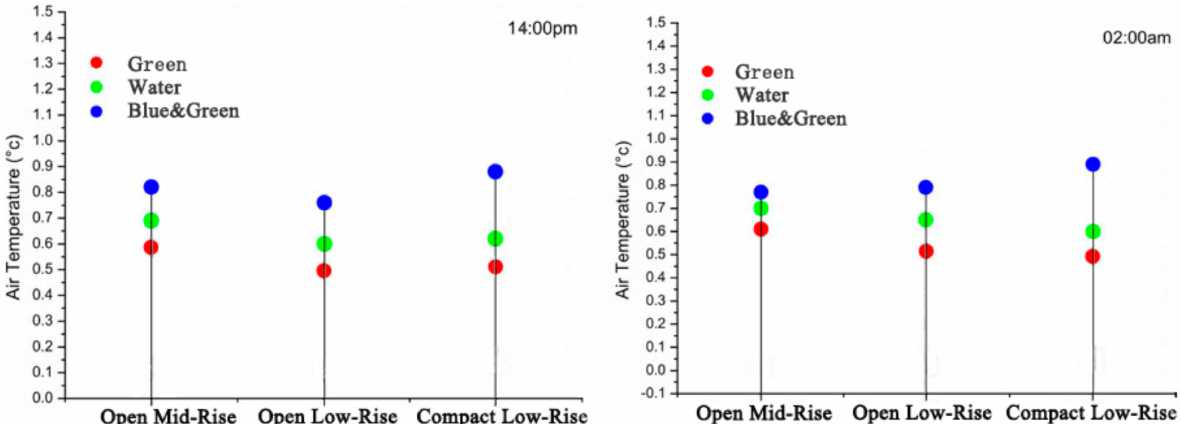
Figure 16. Cooling situation of each model at (14:00 h) and (02:00